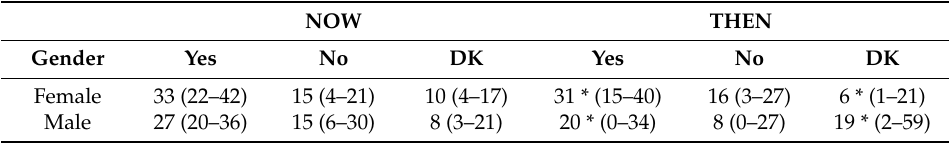
Table 4. Median numbers of “Yes”, “No” and “Don’t know” responses for female and male respondents.